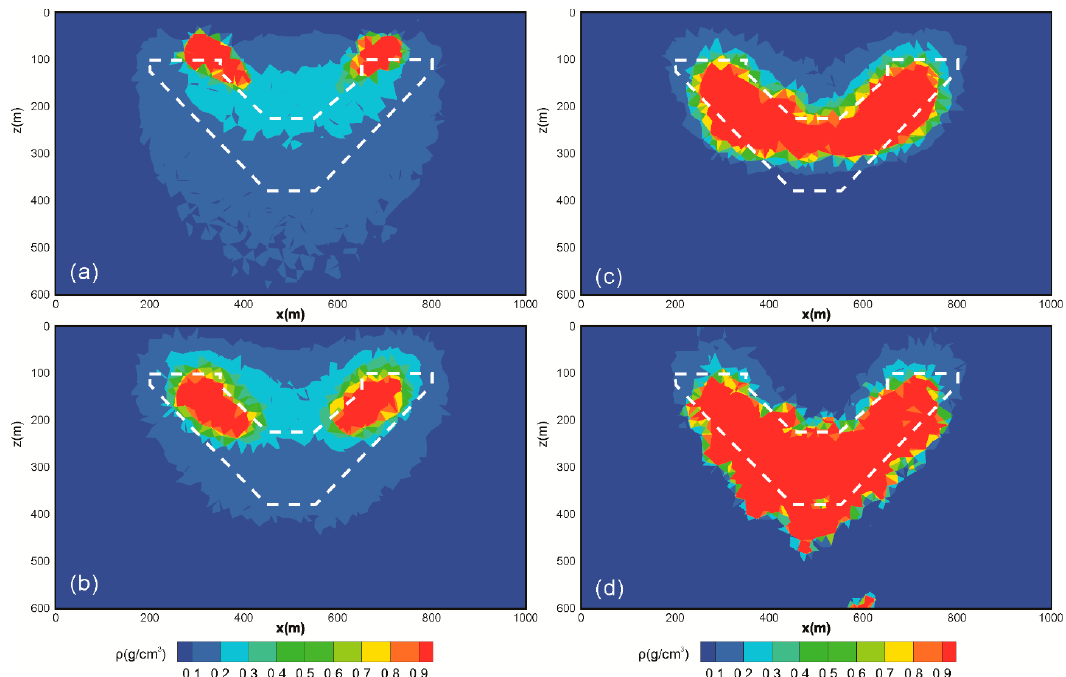
Figure 5. Smooth inversion results. ( a , b ) are conventional strategy with λ = 1 × 10 − 2 and λ = 5 × 10 − 2 ; ( c , d ) are gradient-based strategy with λ = 1 × 10 1 and λ = 5 × 10 1 .